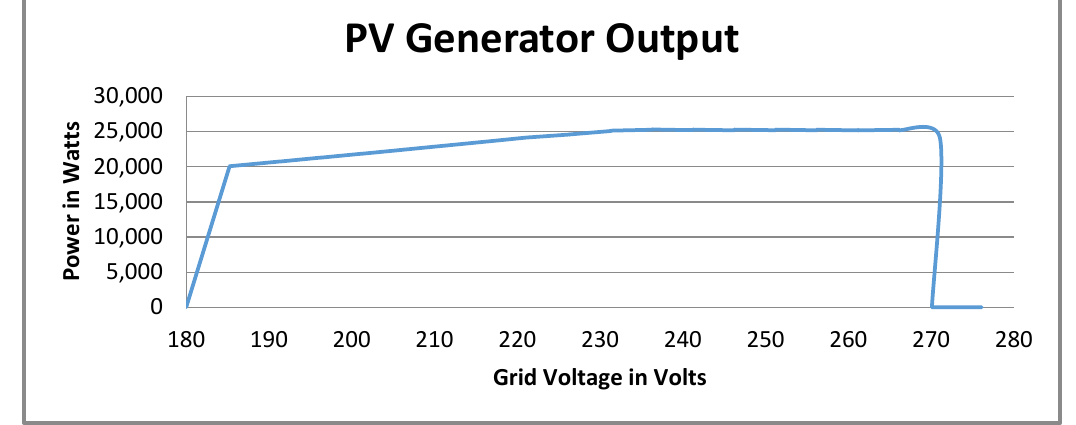
Figure 21. Active power derating with increase in grid voltage in islanded mode of operation.